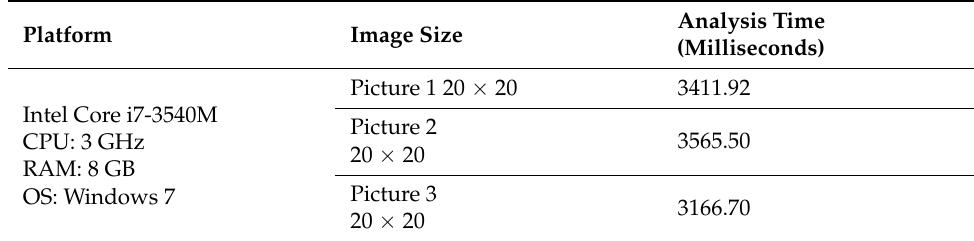
Table 2. Machine learning time.